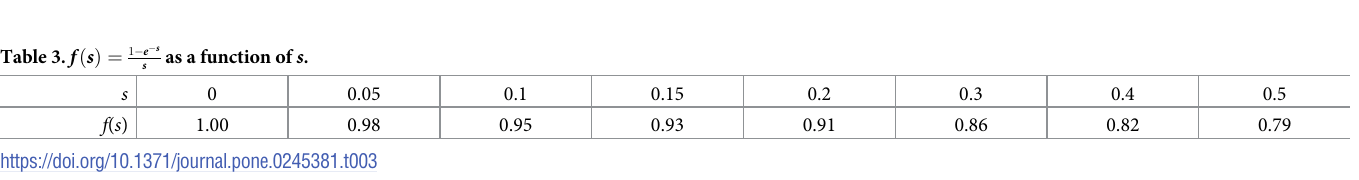
as a function of p . ln ð 1 (cid:0) p Þ p